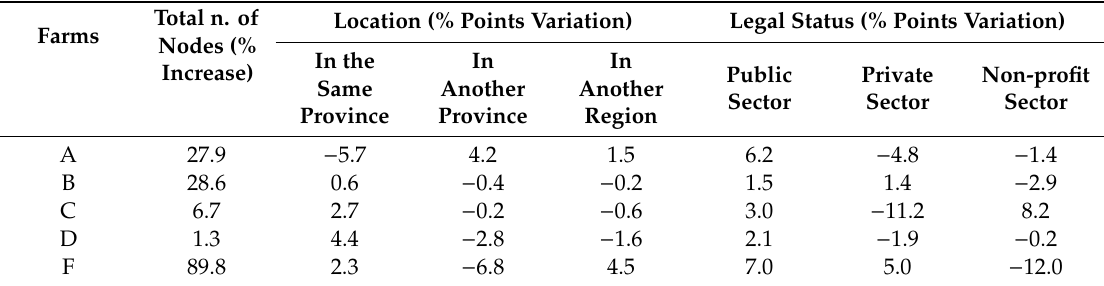
Table 6. Variation over time (T0 − T1) in the number of nodes, their location, and legal status. Total n. of Location (% Points Variation) Legal Status (% Points Variation) Farms Nodes (% In the In In Increase) Same Another Another Province Province Region